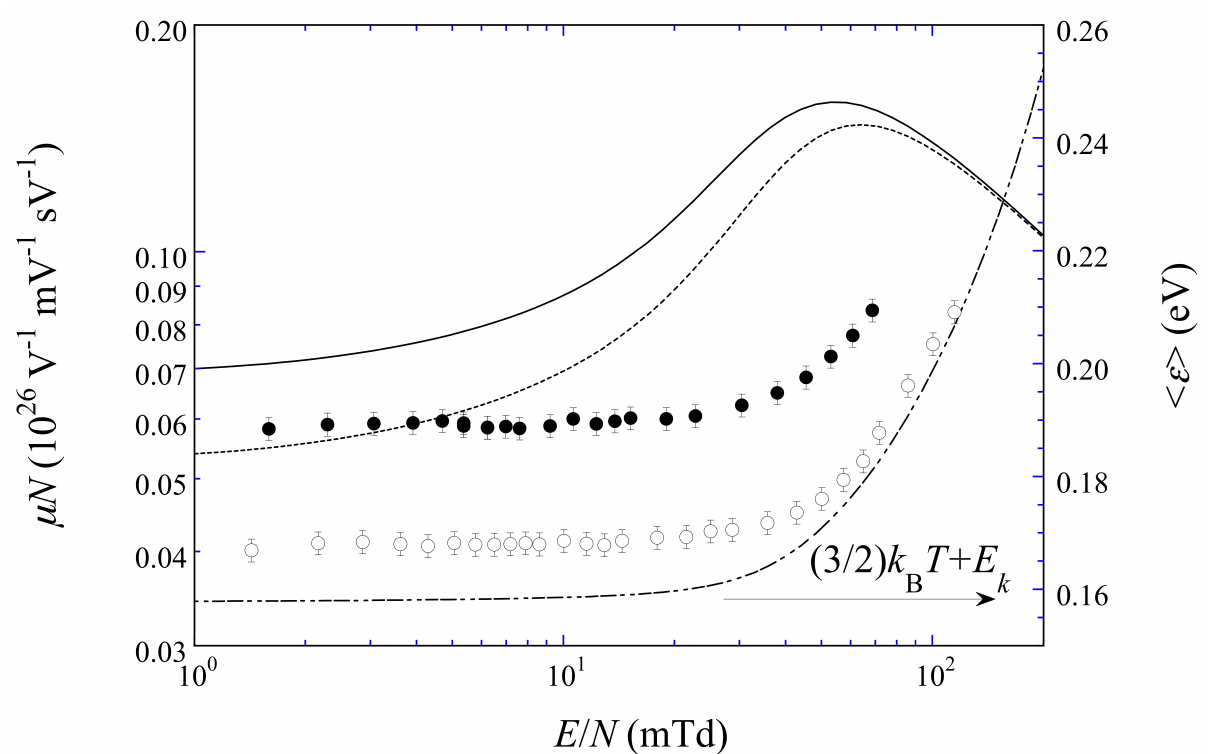
Figure 7. Left scale: µ N vs. E / N for T = 26.1 K for N = 32.36 (closed points) and N = 34.31 (open points). The solid and dotted lines are the predictions of the heuristic model. N is in units of 10 26 m − 3 . Right scale: the average electron energy for N = 34.31 10 26 m − 3 (dash-dotted line), which includes the contribution of E k ( N ) .